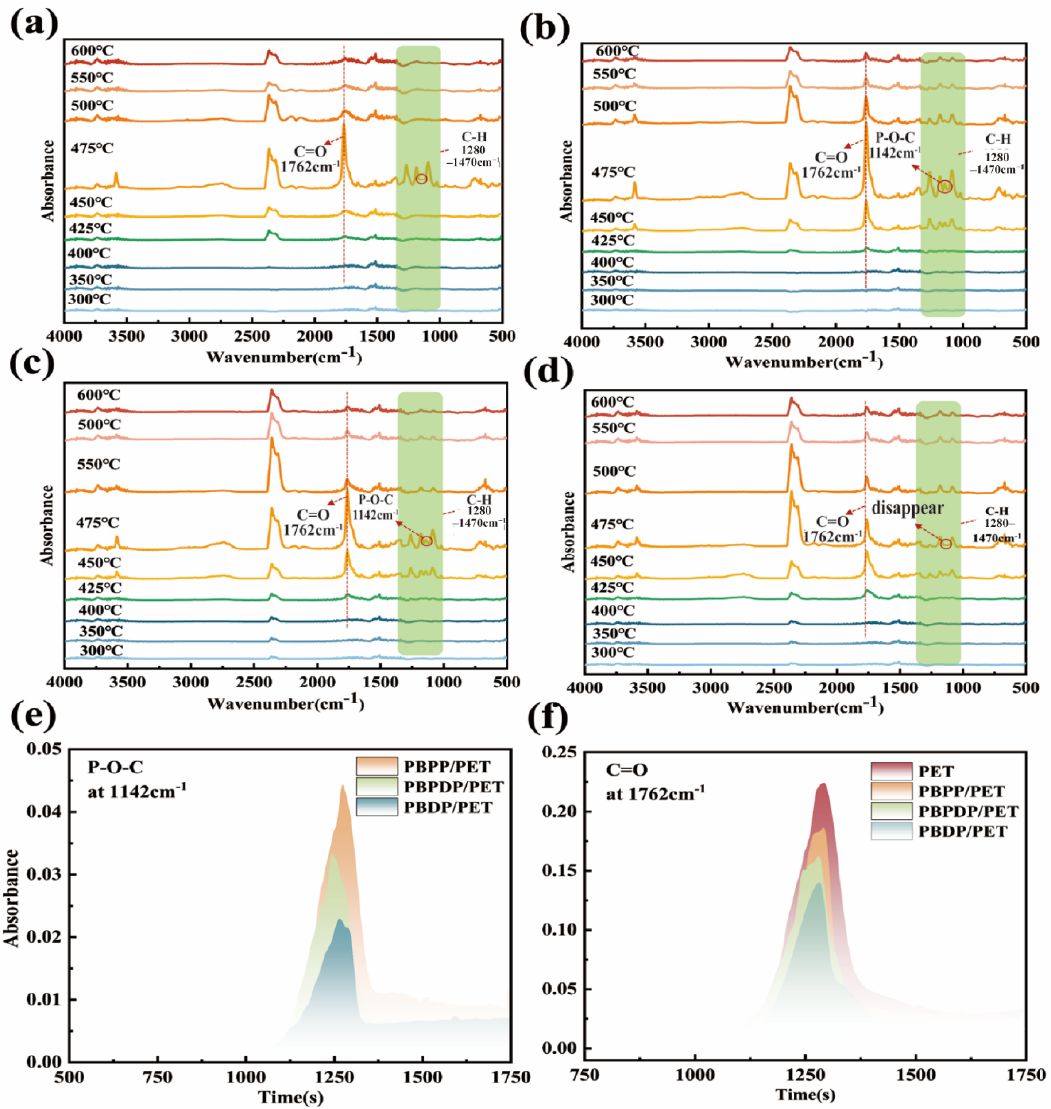
Figure 7. FTIR spectra of volatile pyrolysis products of PET ( a ), PBPP/PET ( b ), PBPDP/PET ( c ) and PBDP/PET ( d ) at different temperatures, and comparison of TG-FTIR spectra of P-O-C ( e ) and C=O ( f ) for PET composites.